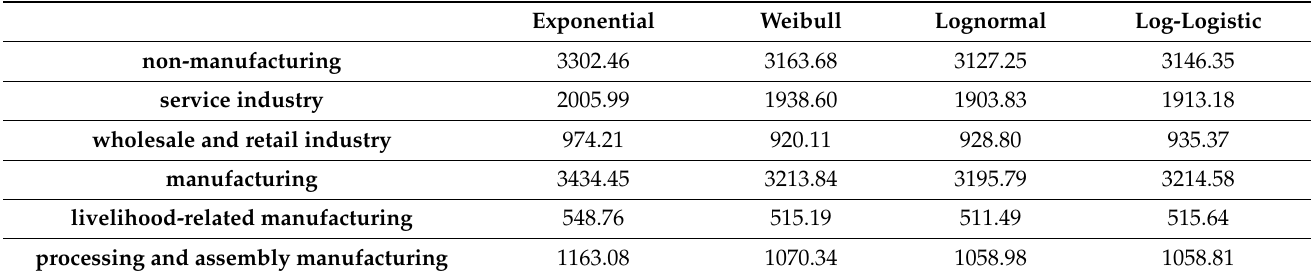
Figure 2. The kernel density curves of non-manufacturing industry and manufacturing industry. Table 2. AIC values of different distributions for